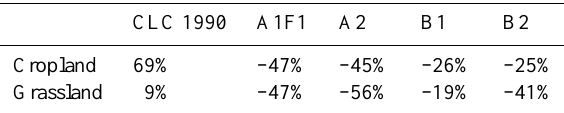
Table 2. Corine land cover of the Hunte catchment for the year 1990 (CLC, 1990) versus average changes in agricultural land use in Germany according to the land use scenarios according to Roun- sevell et al. (2005) until